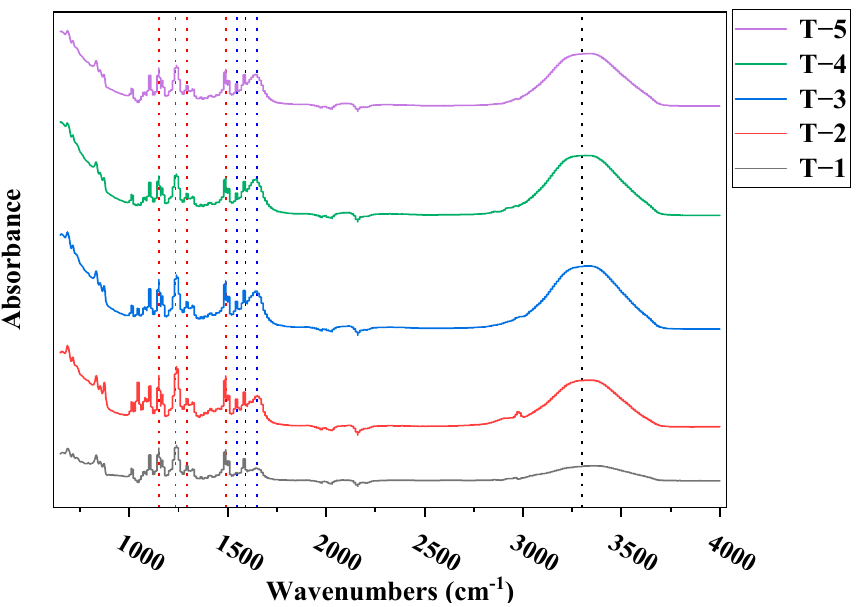
Figure 9. The ATR-FTIR spectra of the TFC-FO membrane with different amounts of MXene